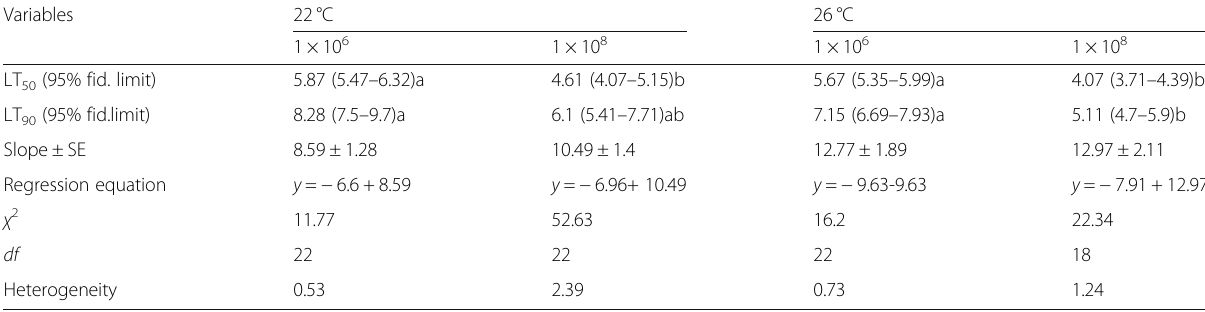
Table 2 The LT 50 and LT 90 values of Baeuveria bassiana against Callebruchus maculatus at two different concentrations and temperatures